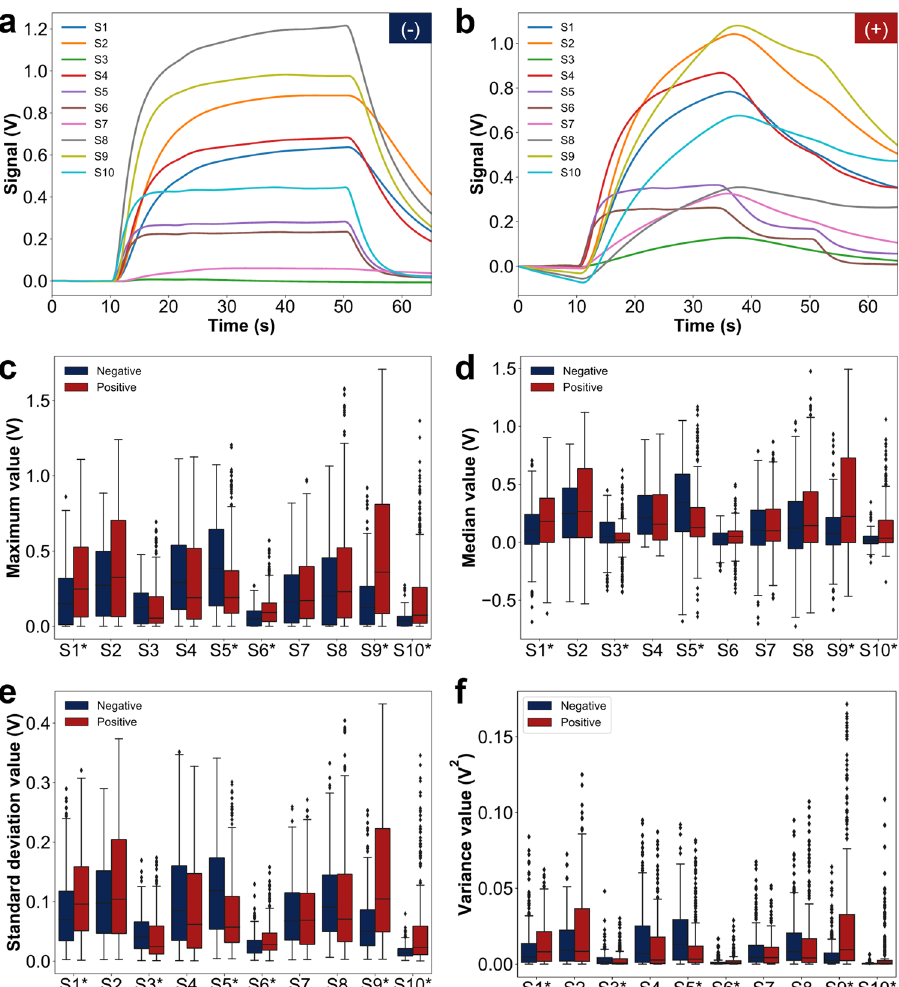
Fig. 3 GeNose 19 sensor responses and their extracted features from the exhaled breaths of RT-qPCR-con fi rmed negative and positive COVID patients. Typical sensing responses were obtained from 10 different conductometric gas sensors (S1 – S10), which are integrated into a portable GeNose C19 system for the exhaled breaths of RT-qPCR-con fi rmed a negative and b positive COVID-19 patients. Boxplots of the distribution for negative and positive COVID-19 samples based on feature extraction: c maximum, d median, e standard deviation, and f variance